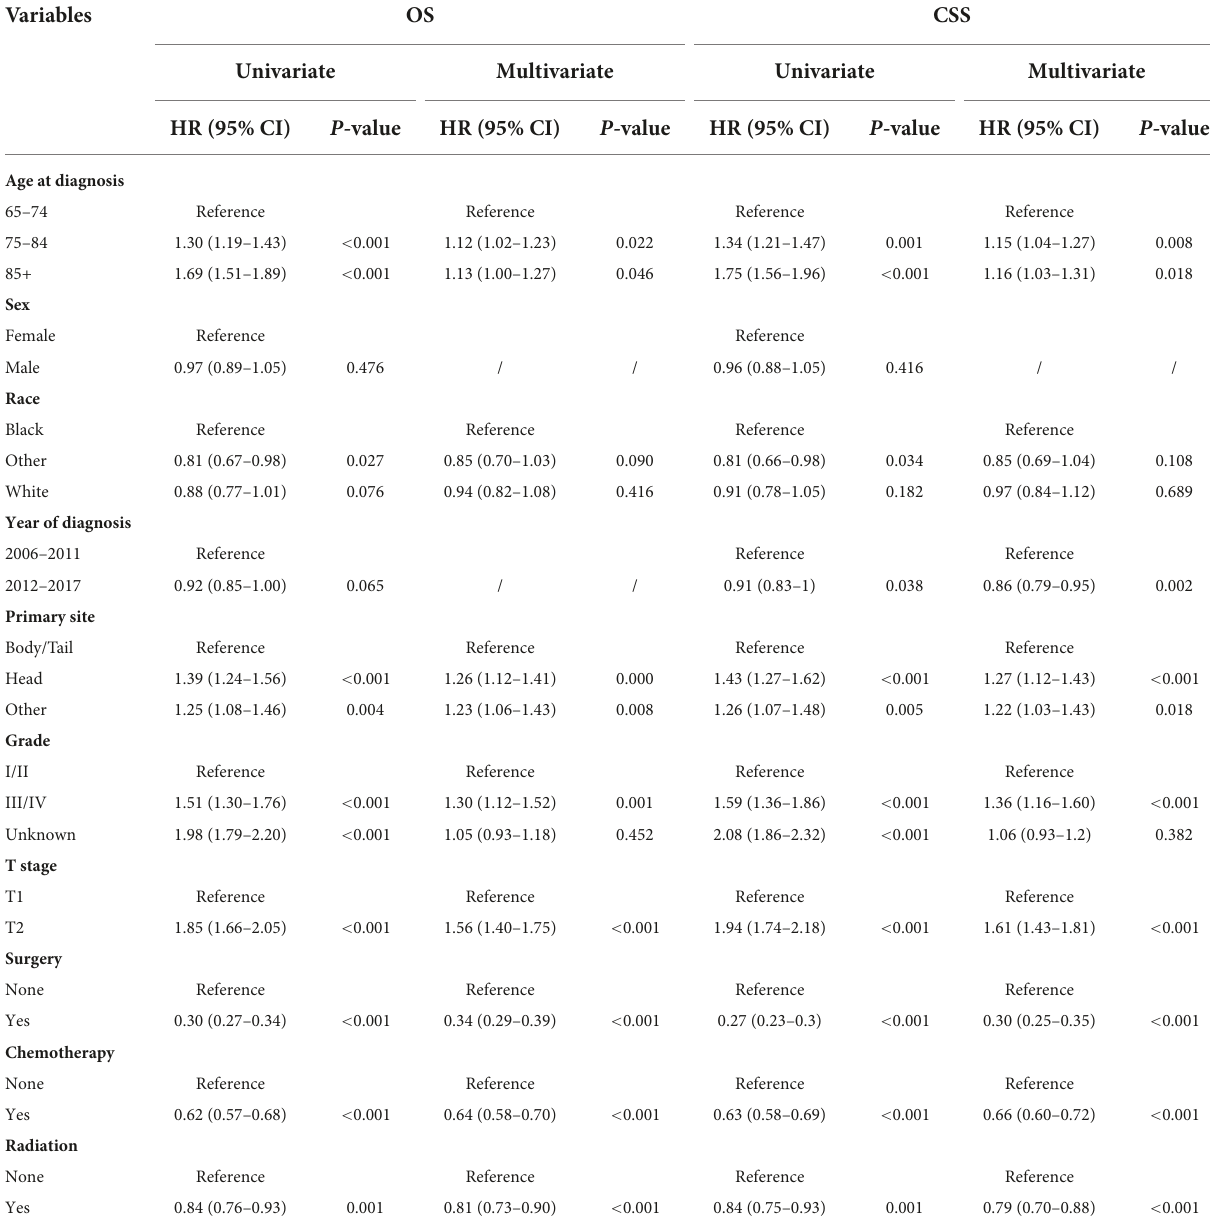
TABLE 2 Univariate and multivariate COX analyses for elderly patients with stage I pancreatic cancer. Variables OS CSS Univariate Multivariate Univariate